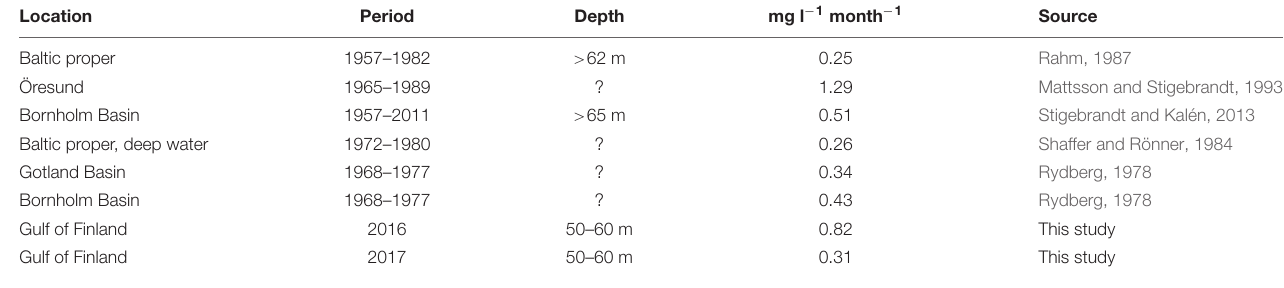
TABLE 4 | Monthly average oxygen consumption results found in the literature.